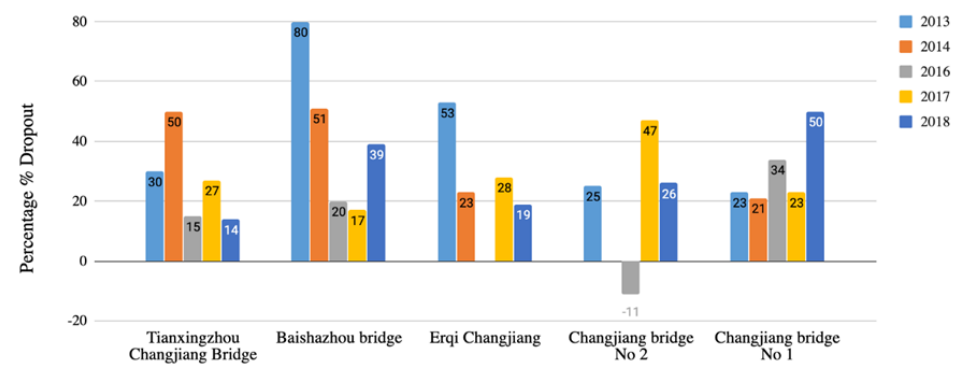
Figure 12. Average major holiday vehicle reduction rate (in %) in 2013–2018 for 5 bridges crossing the Yangtze river within the city of Wuhan, estimated based on the COSMO-SkyMed data analysis.